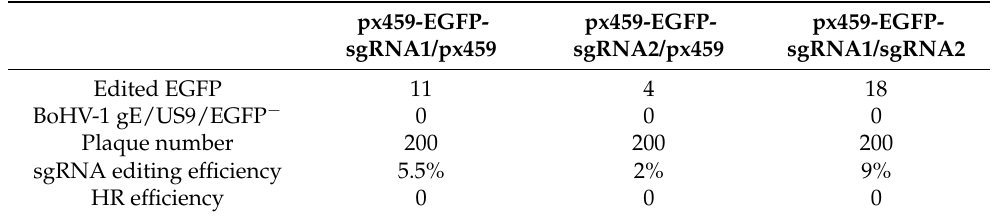
Table 4. Summary of the phenomena that occur in BoHV-1 gE /US9/EGFP − using px459-EGFP-